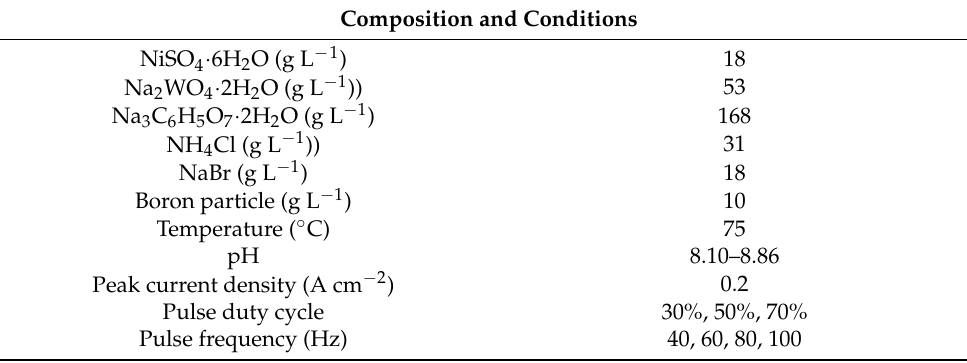
Table 1. Basic bath compositions and electrodeposition